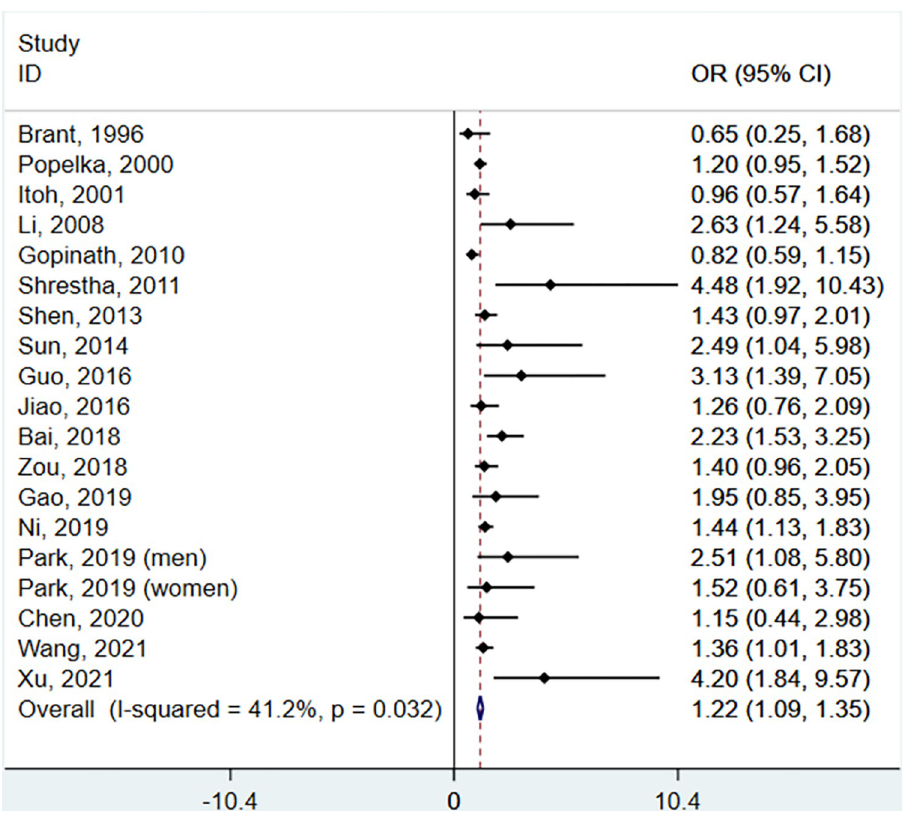
Fig 2. Summary estimates were calculated using fixed-effects models. Note . Abbreviations: CI, confidence interval; OR, odds ratio.